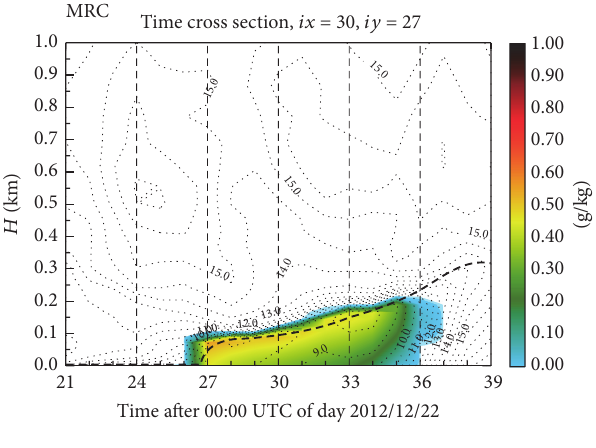
Figure 11: Temporal evolution (from 22/12/2012 at 21 UTC to 23/12/2012 at 15 UTC) of simulated air temperature (lines in ∘ C) and liquid water mixing ratio (color scale in g/kg) over Beja Air Base nearest grid point of D2 domain. Fog > 0.05 g/kg liquid water mixing ratio (Introduction